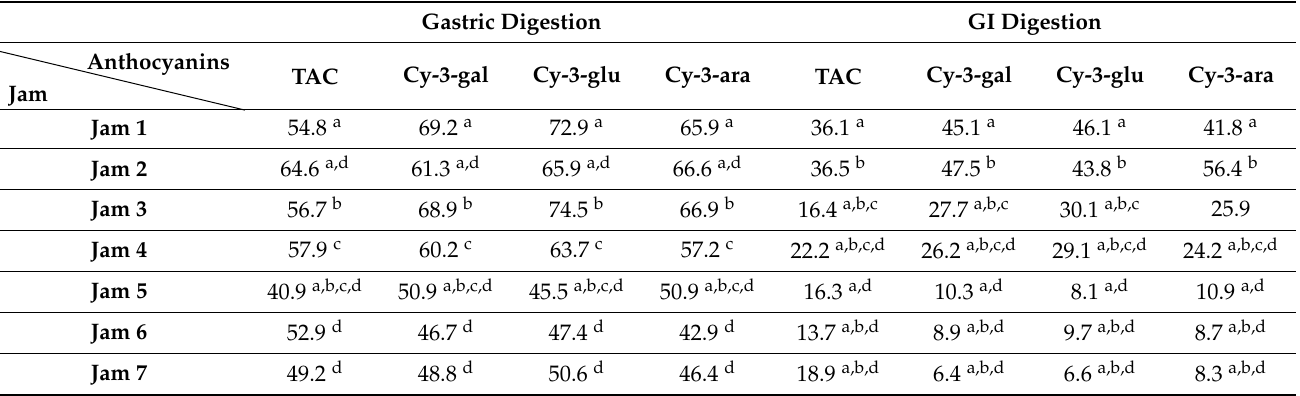
Table 2. Bioaccessibilities of TAC and individual anthocyanins: cyanidin-3-galactoside (cy-3-gal), cyanidin-3-glucoside (cy-3-glu) and cyanidin-3-arabinoside (cy-3-ara) during in vitro simulated digestion of lingonberry jams, expressed as